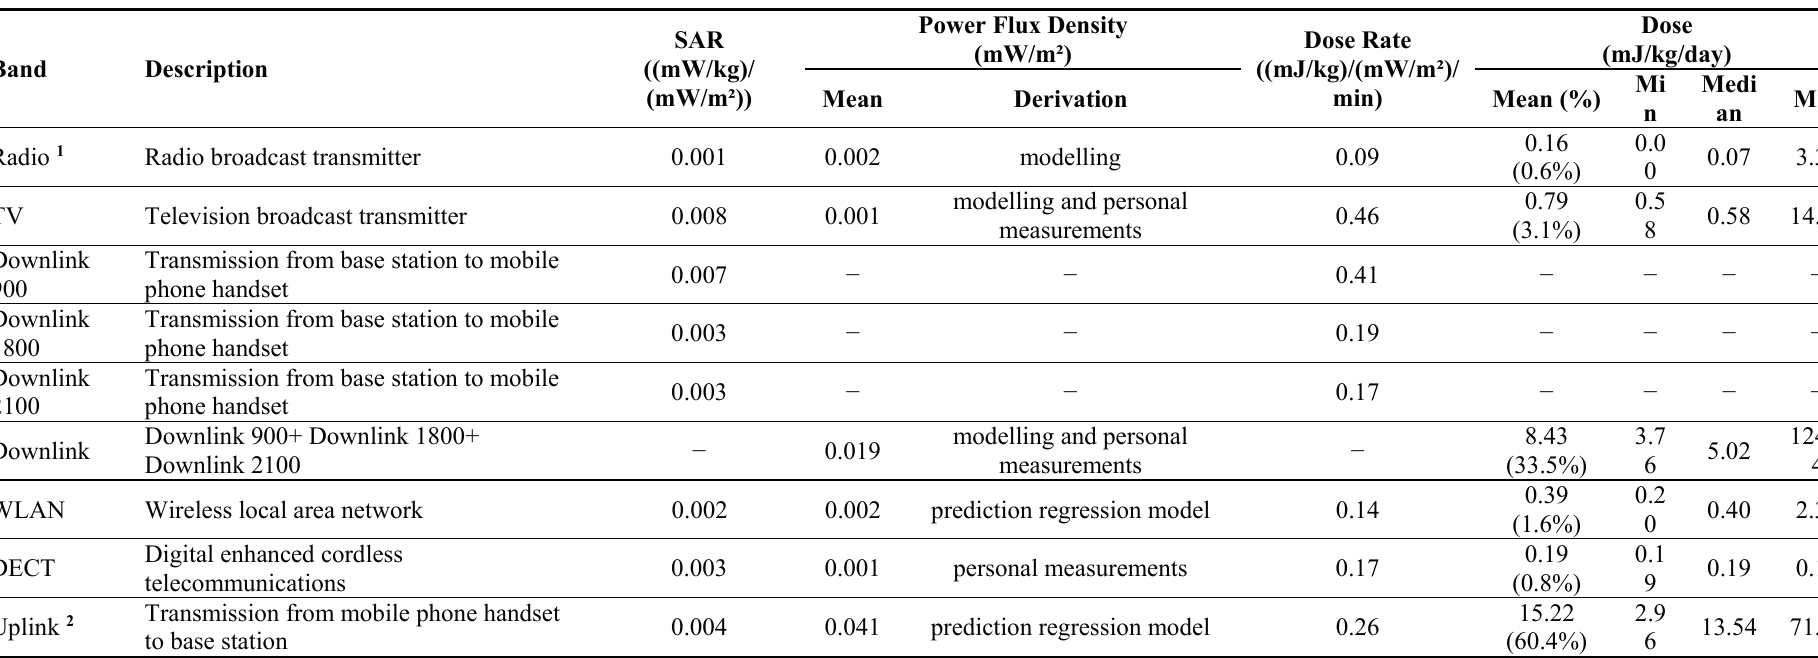
Table 4. Brain SAR, mean and derivation of the power flux density, brain dose rate (dose per 1 min) and mean (with the corresponding percentage of the total brain far-field dose), minimum, median and maximum of the brain dose for the far-field